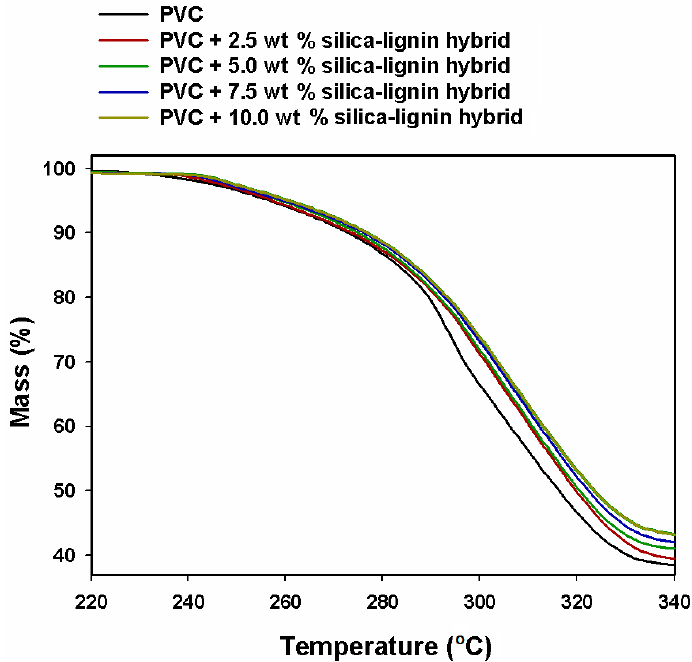
Figure 6. TG curves of PVC and PVC–silica–lignin composites with various filler contents.